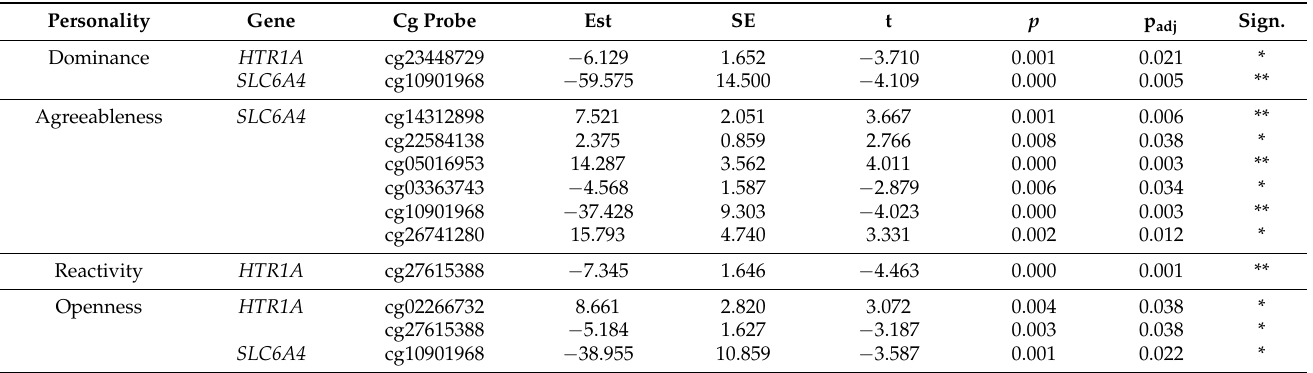
Table 3. Model statistics for HTR1A and SLC6A4 individual CpG scores and their significant associa- tions with personality dimensions in chimpanzees.